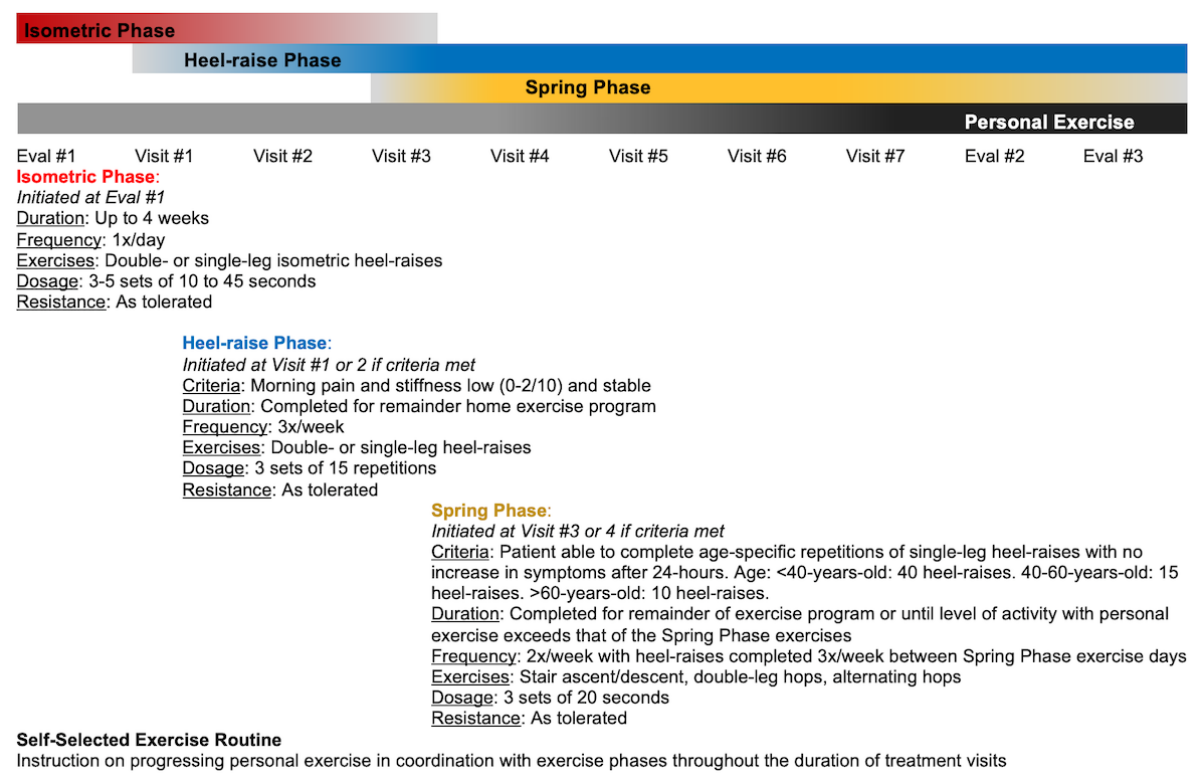
Figure 2. Progressive tendon-loading exercise program with 4 overlapping phases (isometric, heel raise, spring phase, and self-selected exercise). Participants are encouraged to maintain any ongoing personal exercise throughout the study, and then receive additional instruction on progression